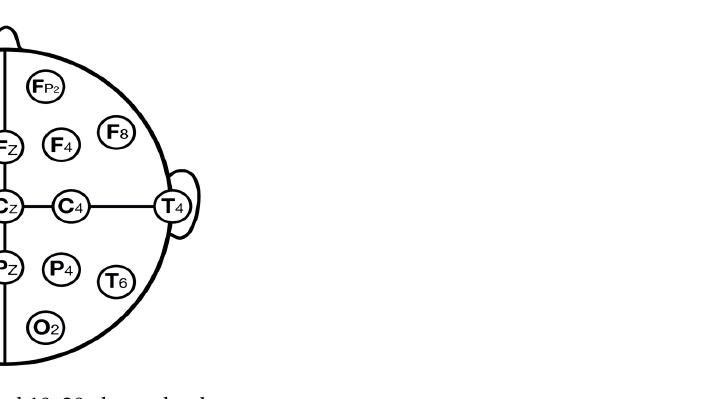
Figure 1. International 10–20 electrode placement system.